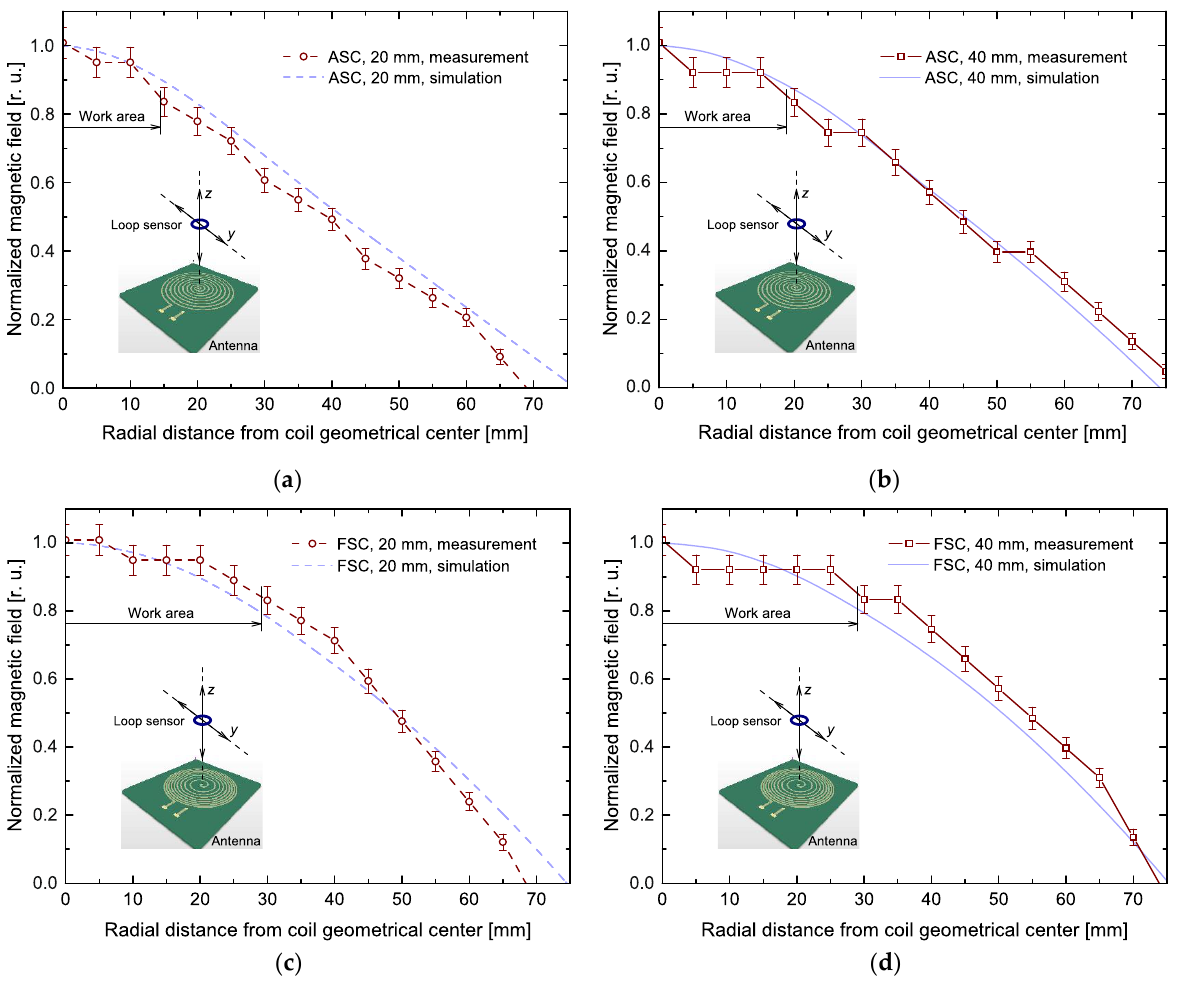
Figure 9. Comparison of experimental and simulation results of magnetic-field decay at the frequency 4.645 MHz: ( a ) at a distance of 20 mm from the Archimedean spiral coil; ( b ) at a distance of 40 mm from the Archimedean spiral coil; ( c ) at a distance of 20 mm from the Fermat spiral coil; ( d ) at a distance of 40 mm from the Fermat spiral coil. Table 4. Comparison of the working areas of the investigated coils.